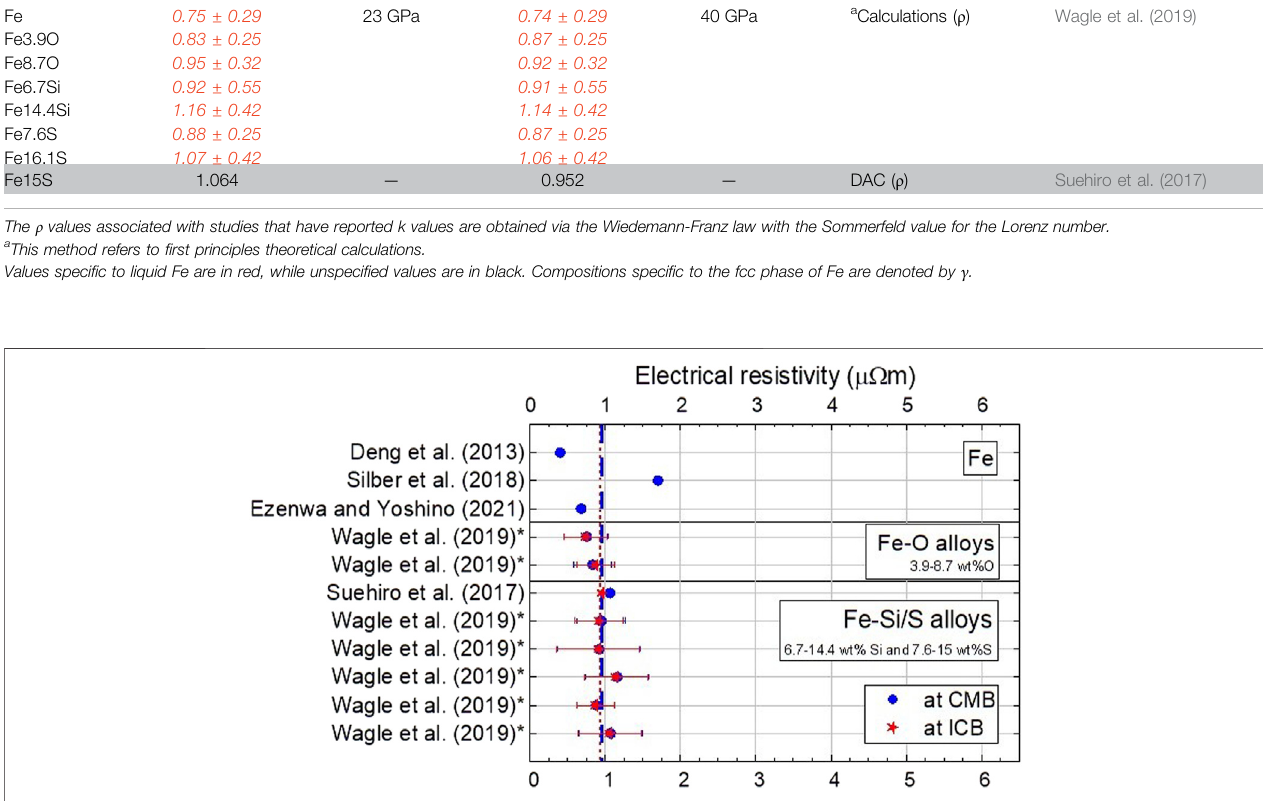
TABLE 8 | Electrical resistivity values of Fe and Fe-alloys according to different methods, at Ganymede ’ s CMB. Composition